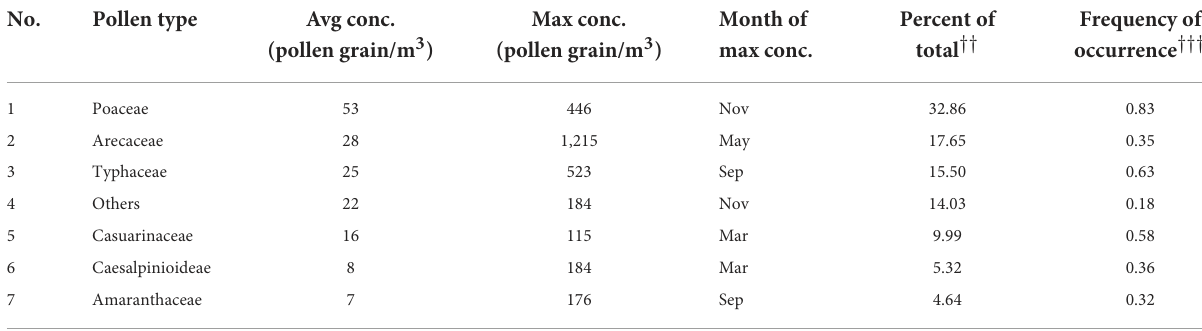
TABLE 1 Variation of airborne pollen concentration throughout the year of this study †